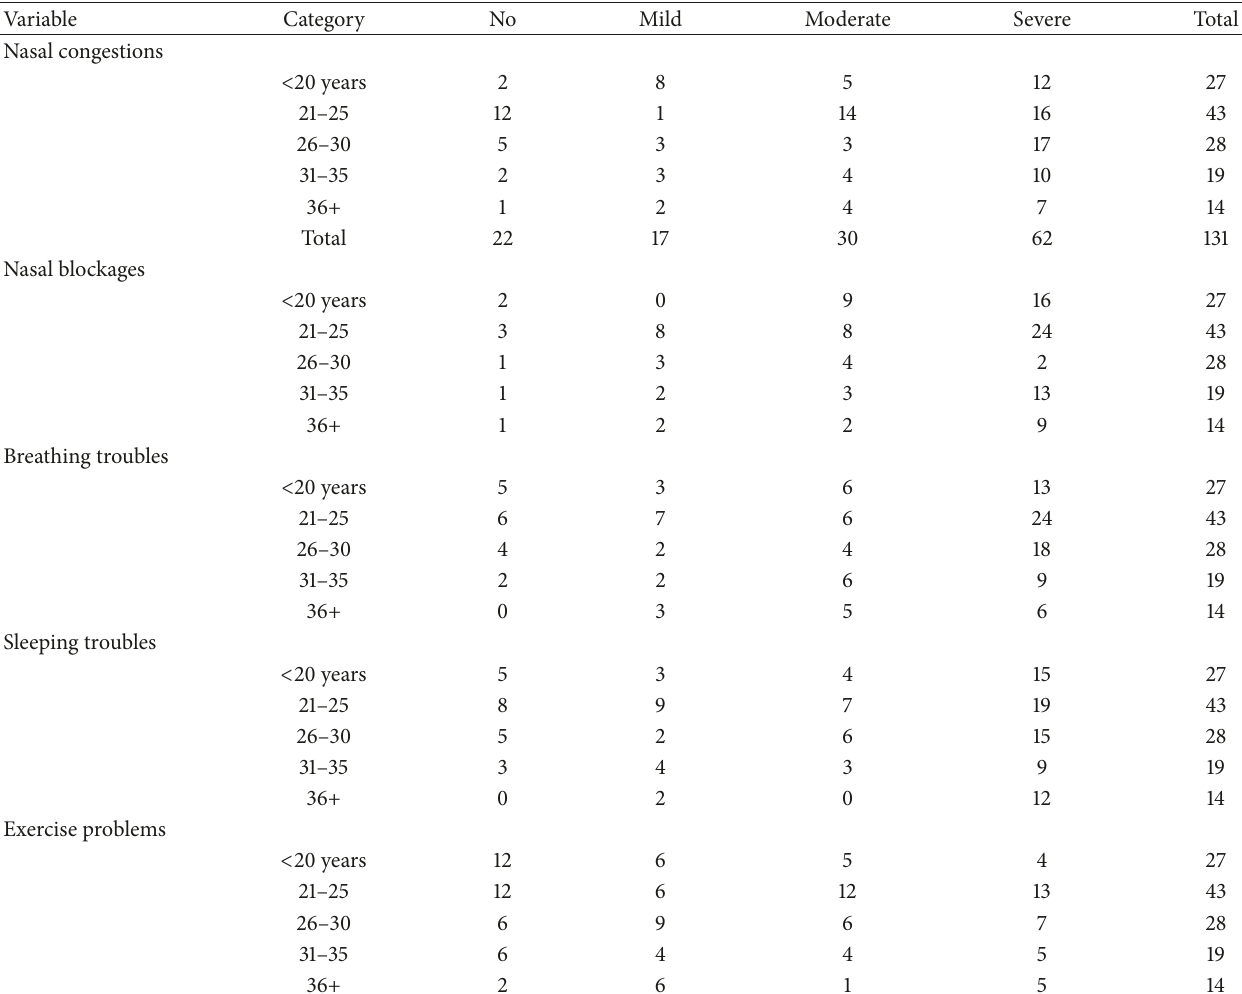
Table 4: Distribution of the study subjects by age and clinical